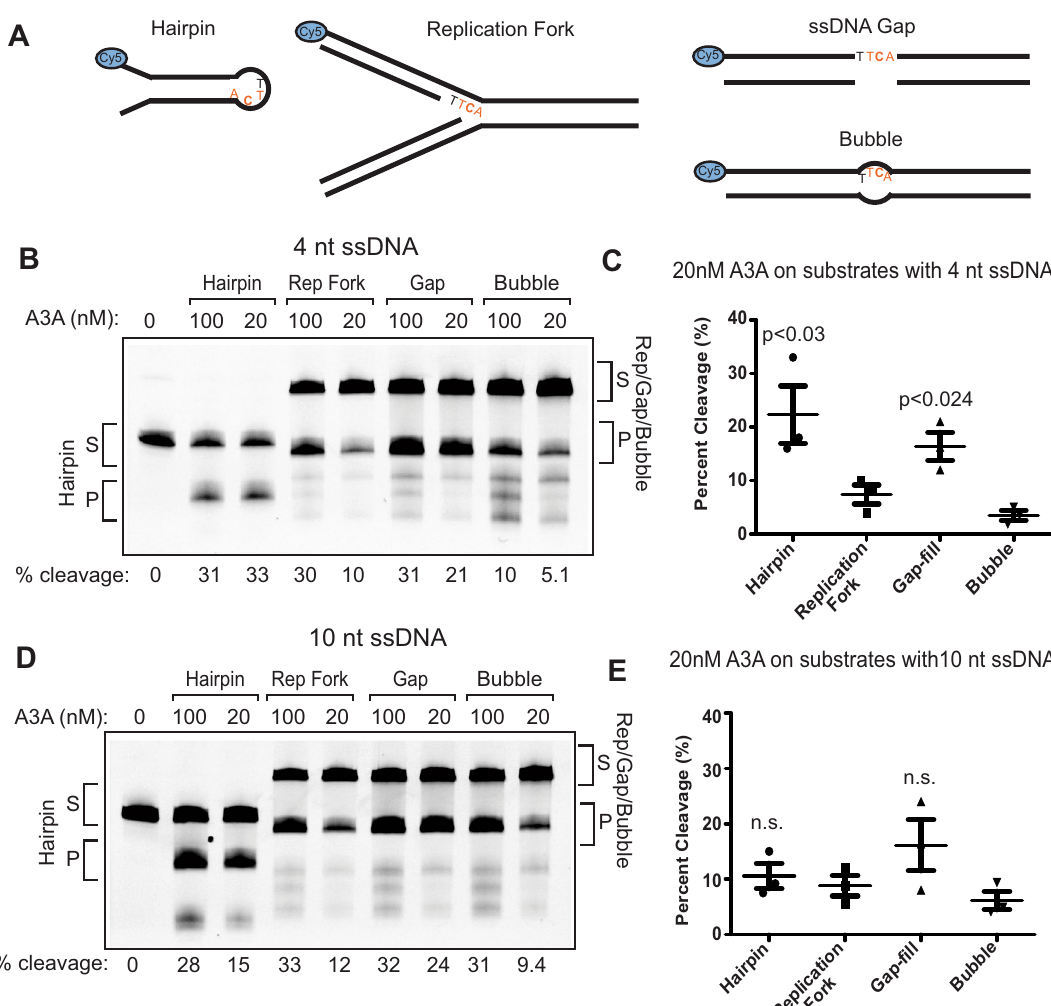
Figure 3. APOBEC3A prefers hairpin substrates over other structures that are possible sources of ssDNA. ( A ) Graphical representation of ssDNA substrates tested. All substrates contained a TTCA motif and were 5 ′ Cy5 tagged. Structures with double-stranded regions were confirmed prior to use (Fig. S2). ( B ) Deaminase assay of 100 nM A3A, 20 nM A3A, or no A3A was incubated with 20 nM hairpin, replication fork, ssDNA gap, or bubble substrates containing 4 nt spans of ssDNA. Assays were performed and processed as in Fig. 1C. S denotes substrate band; P denotes the product band. ( C ) Quantification of 3 deaminase assay replicates was conducted as described in ( B ). P-values indicate significant differences in A3A activity comparing the hairpin and ssDNA gap substrates pairwise to the replication fork and bubble substrates by t-test. Deamination efficiency was displayed as percent cleavage of each substrate by 20 nM A3A. Error bars indicate standard error of the mean. ( D ) Deaminase assay of 100 nM A3A, 20 nM A3A, or no A3A with 20 nM of hairpin, replication fork, ssDNA gap, or bubble substrates with longer spans of ssDNA (10 nt). Assays were performed and processed as in Fig. 1C. S denotes substrate band; P denotes the product band. ( E ) Quantification of 3 replicate deaminase assays was conducted as in ( D ) and displayed as in ( C ). n.s. indicates no statistical difference was observed in activities among substrates. Full-length gel images for 3B and 3D are presented in Fig.